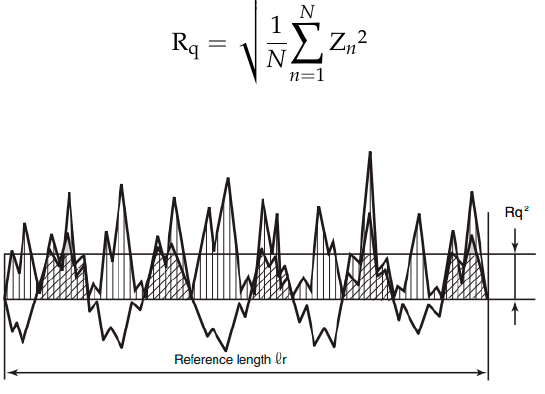
Figure 2. Illustration of R q.